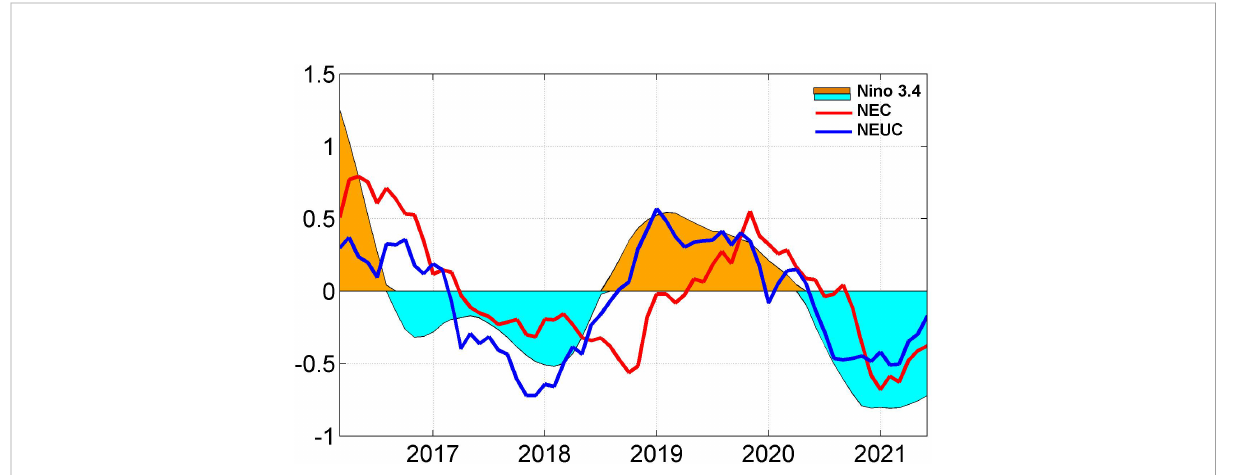
FIGURE 12 The normalized zonal velocity time series of NEC (blue) and NEUC (red) at 8.5°N derived from mooring measurements during 2016-2021. Shading denotes the Niño3.4 index. Here the normalized NEC velocity is de fi ned as the mean zonal velocity averaged between 50-150 m, which is scaled by its standard deviation. The de fi nition of normalized NEUC is same as the NEC but for the depth range of 300-800 m. All curves are smoothed with a 1-year low-pass fi